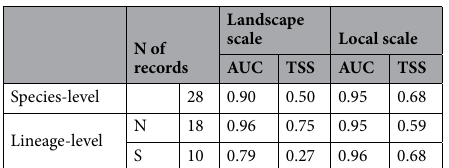
Table 1. Number of records used to construct models, and performance of different evolutionary level models at the landscape and local spatial scales based on the Area Under the Curve of Receiver Operating Characteristic (AUC) and True Skill Statistic (TSS).